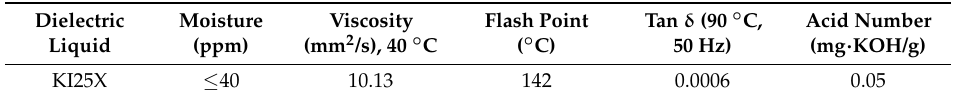
Figure 2. The schematic diagram of the electrodes (mm). ( a ) cylinder-plan electrodes; ( b ) cone-plan electrodes; ( c ) sphere-plan electrodes; and, ( d ) sphere-sphere electrodes used for the investigation of the breakdown voltage of the pressboard. Table 1. Characteristics of the tested oils.